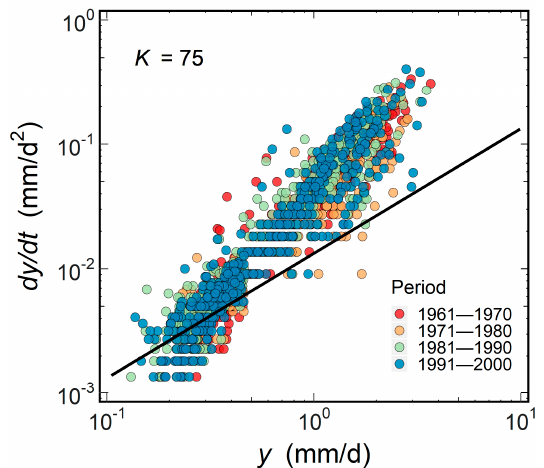
Figure 6. Zangbo River basin over the period of 1961–2000. Scatter plot of log( − dy / dt ) versus log( y ) showing the recession slope of low flow records. The black line is the lower envelope for estimating the characteristic drainage timescale ( K ). The colour of the points was filled according to the observation year.